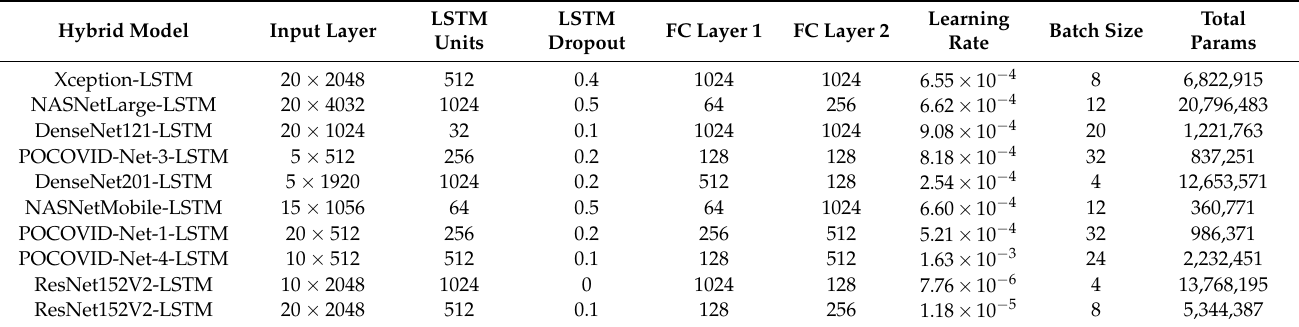
Table 7. Summary of the hyperparameters of the top 10 best hybrid